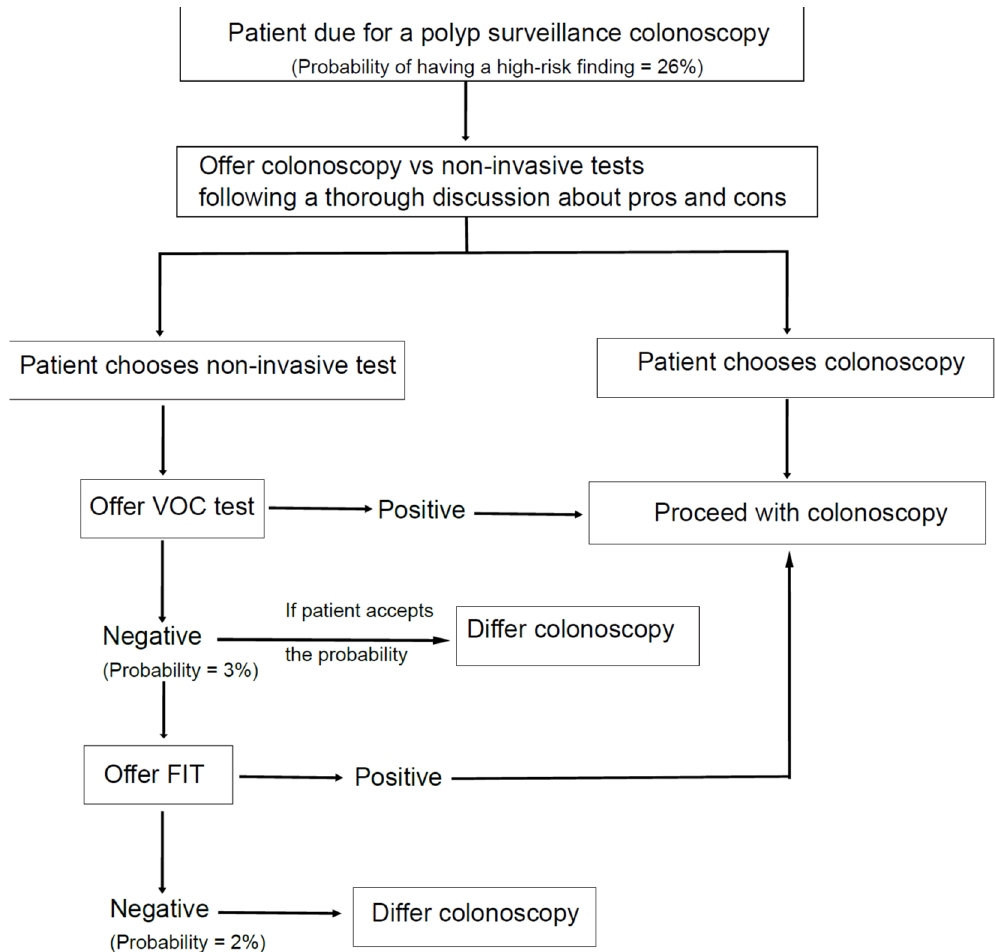
Figure 6. Proposed algorithm using non-invasive tests as a triage tool in polyp surveillance. Probability = probability of having a high-risk finding following a negative test.